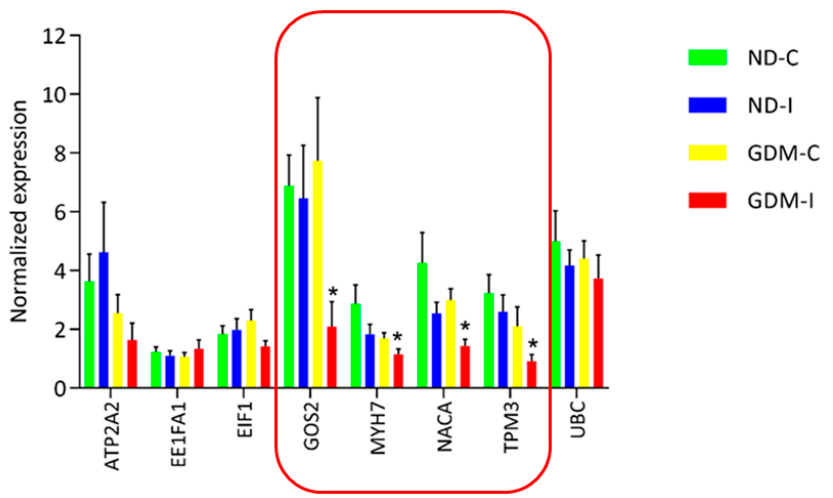
Figure 7. Real-time RT-PCR analysis of eight differentially expressed genes in RAM. Real-time RT- PCR was carried out on six independent biological replicates per group containing three replicates. The relative quantification of each transcript was normalized against β -actin and GAPDH. In the featured line, there are genes that were differentially expressed by RT-PCR in a larger group of analyzed women. * ND-C: non-GDM continent women (no PSUI); ND-I: non-GDM incontinent women (with PSUI); GDM-C: GDM continent women (no PSUI); GDM-I: GDM incontinent women (with PSUI).